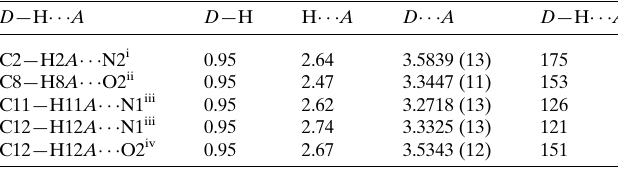
Table 2 Hydrogen-bond geometry (A˚ , (cid:2) ) for m -C 15 H 10 N 2 O 2 .